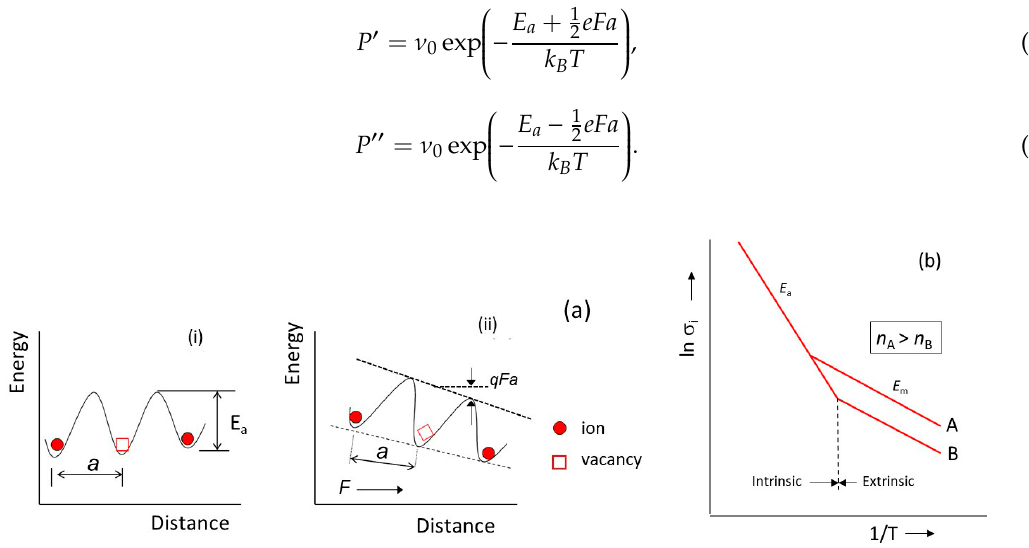
Figure 2. ( a ) Scheme of the potential barrier, which an ion has to overcome to exchange its site with a vacancy: (ii) Without external electric field and (ii) with external electric field. ( b ) Arrhenius plot of the ionic conductivity (ln σ i vs. 1/ T ). The intrinsic and extrinsic regions are characterized by different E a values.